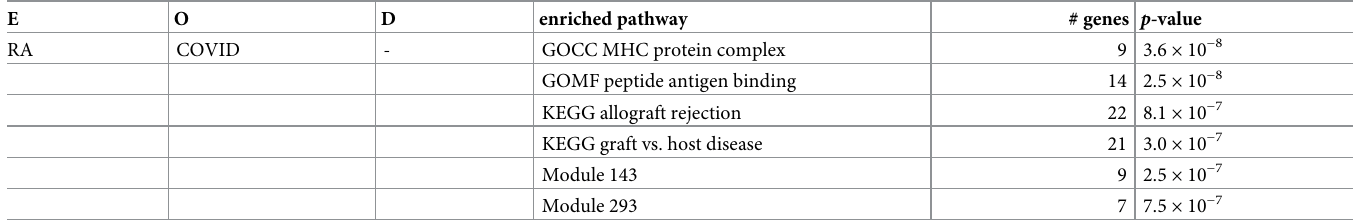
Table 4. Bonferroni significant pathways for the ratio test. We tested against the 32284 gene sets of MSigDB 7.4. We list Bonferroni significant pathways ( p < 0.05/ 32284/7 ’ 2.2 × 10 − 7 ) and pathways close to significance. E O D